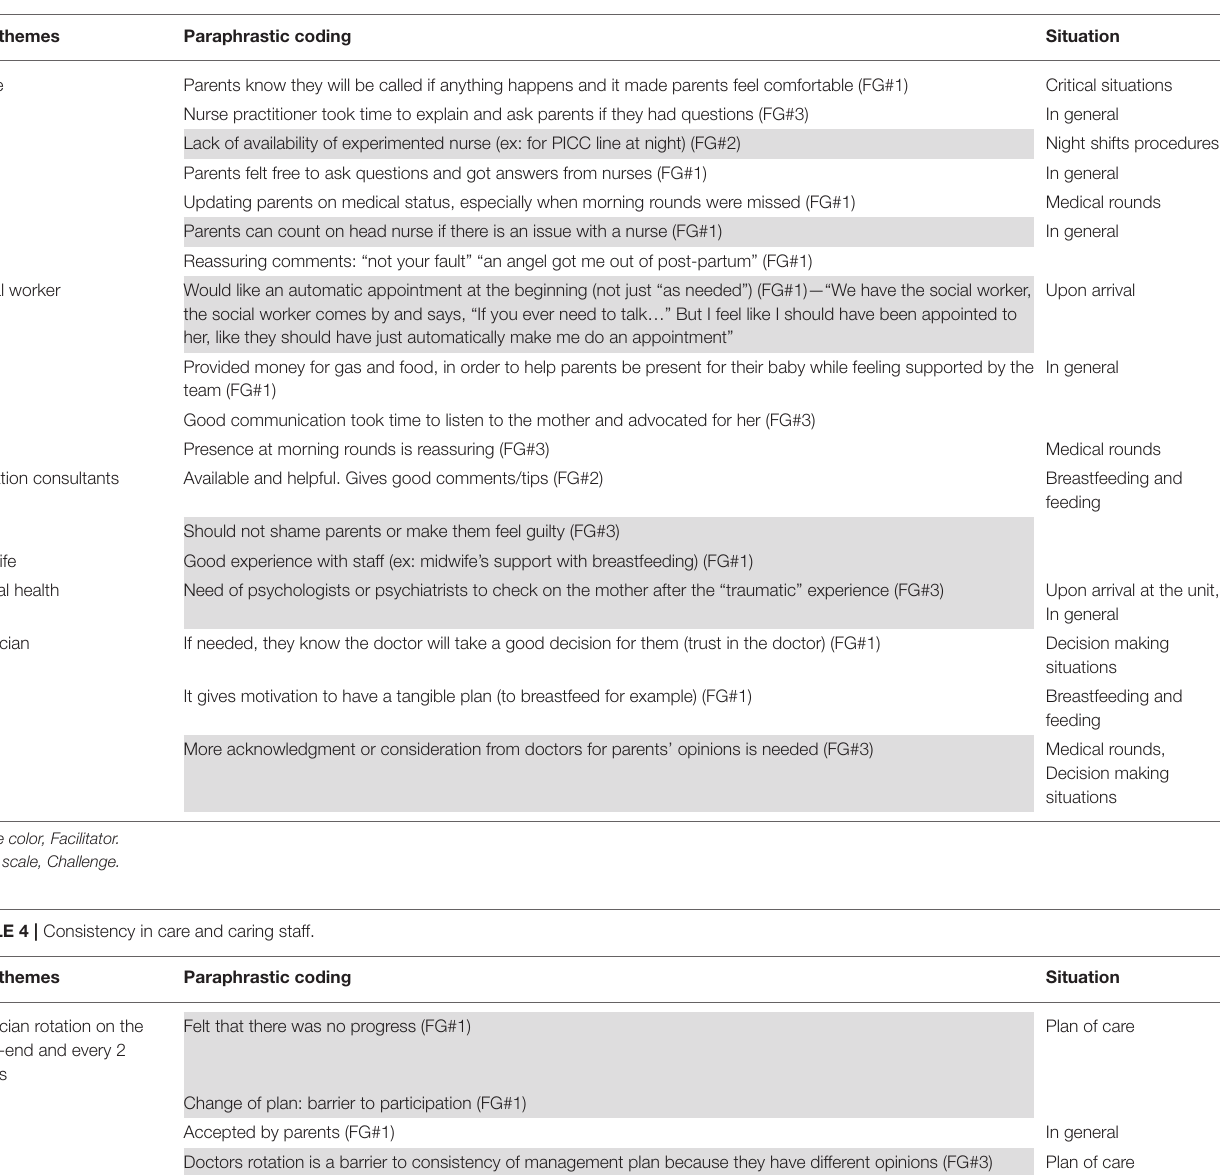
TABLE 3 | Supportive/trustworthy healthcare professional.